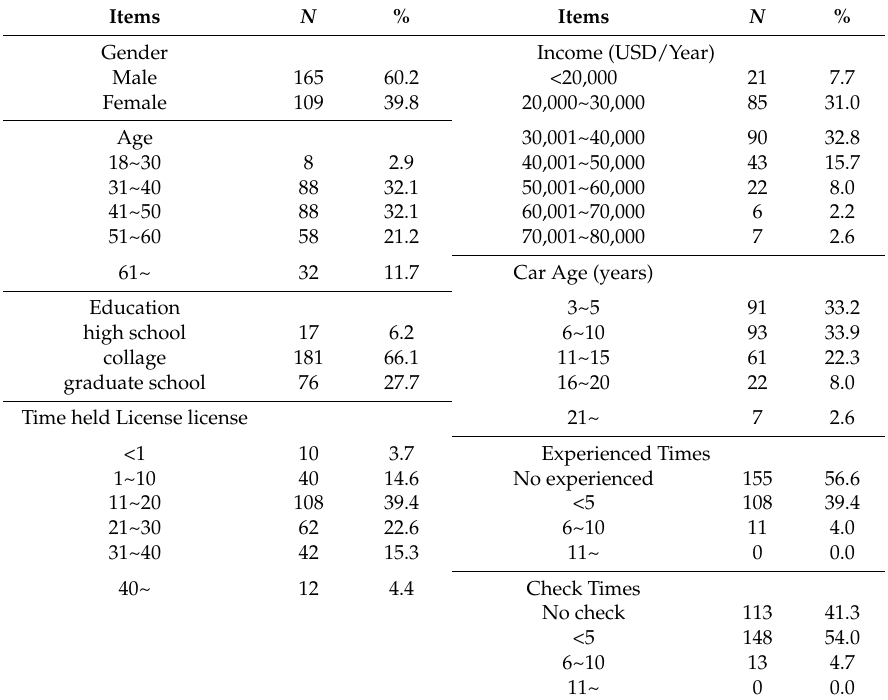
Table 2. Demographic information of respondents in this